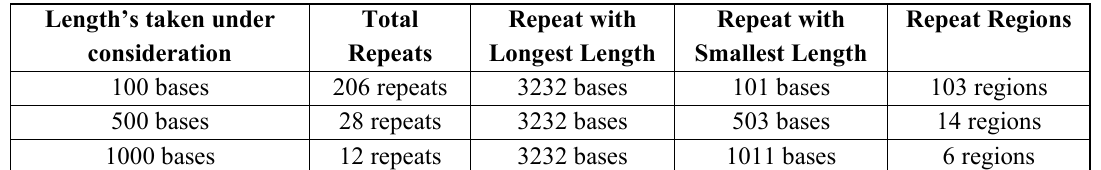
Table 5. S. cerevisiae (Brewer's yeast) First and Eighth Chromosome’s Repeats Having 100% Similarity